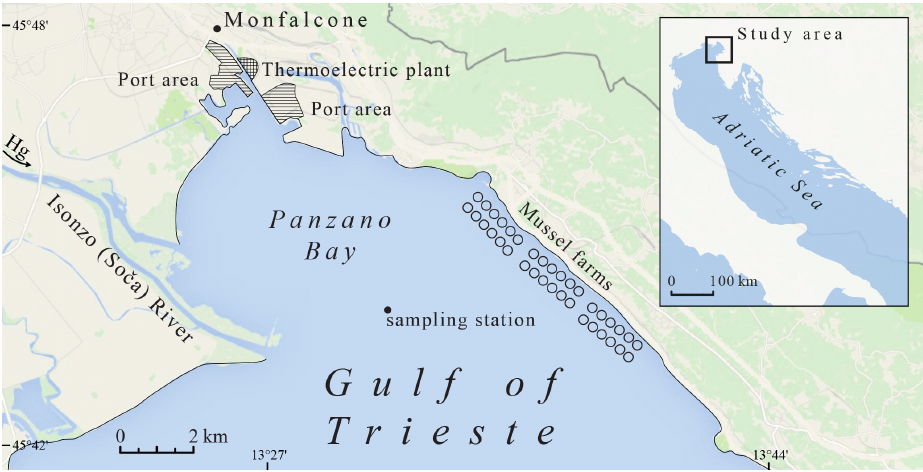
Figure 1. Study area and location of sampling site in Panzano